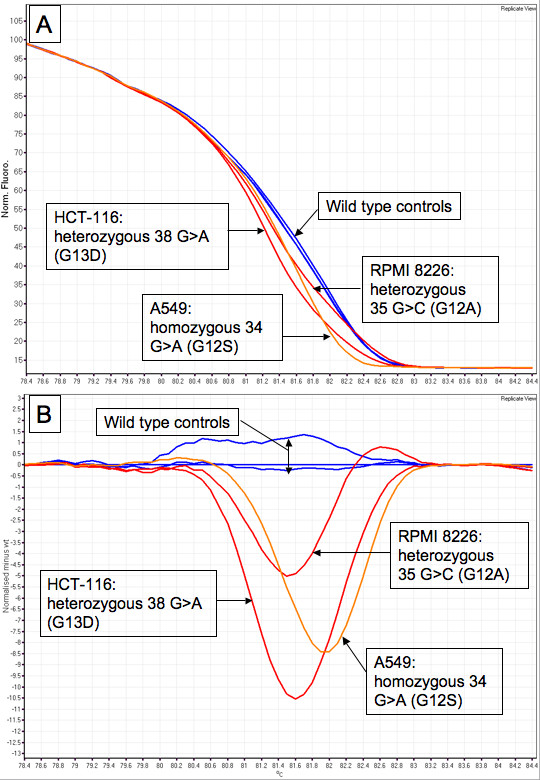
Difference plots of KRAS mutated cell lines. Panel A: A normal plot of the wild-type controls with the cell line samples. Fluorescence is on the Y-axis and temperature in degrees Celsius is on the X-axis. Panel B: A difference plot of the wild-type controls with the cell line samples. All cell line samples were compared to the median wild-type control sample to produce the plot.